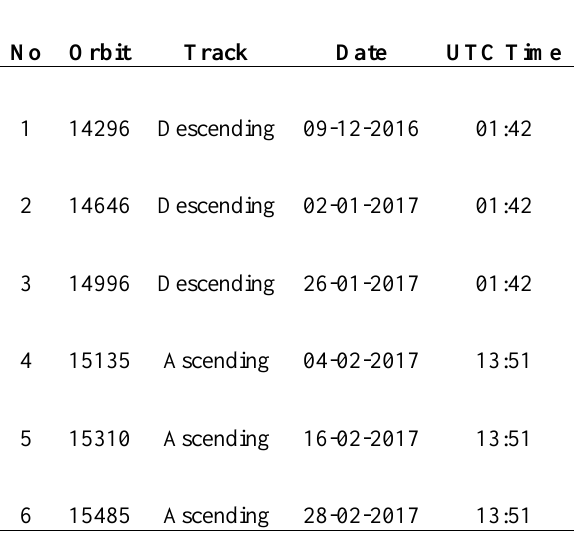
Table 1 . Sentinel-1 Wide Swath SAR Satellite data used for this